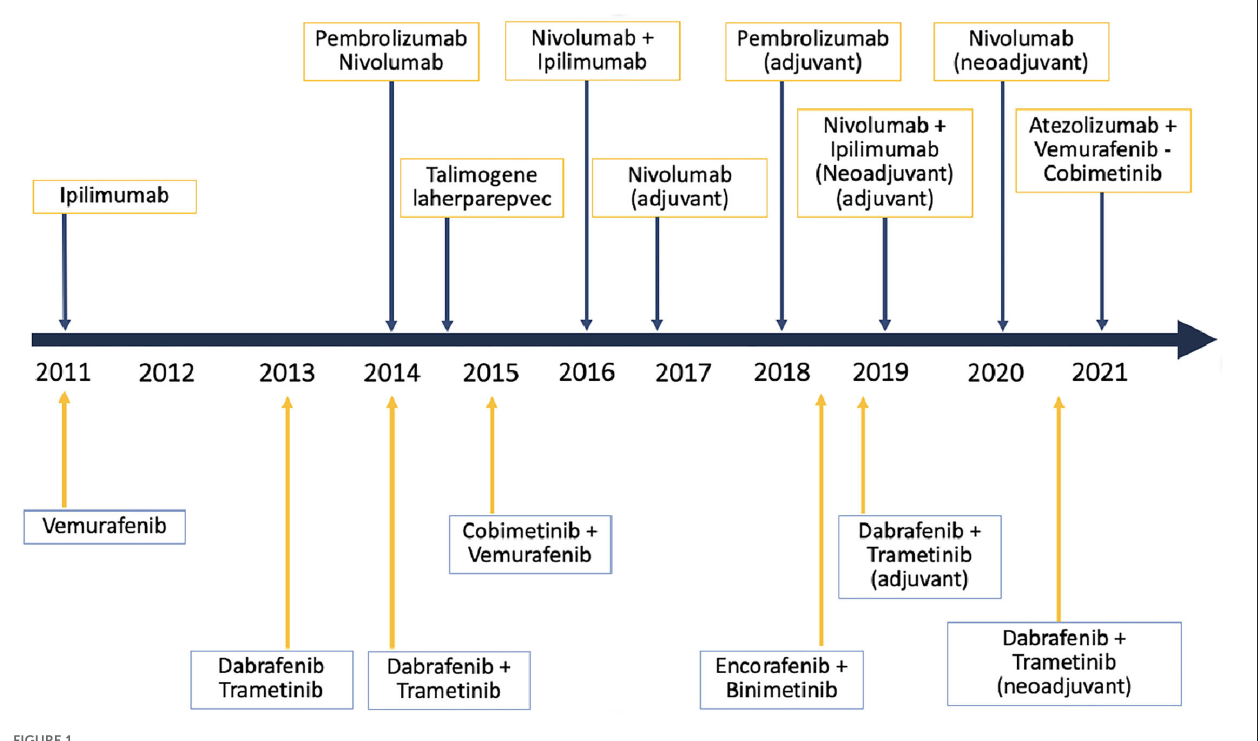
FIGURE1 Timeline of target therapies and immunotherapy in